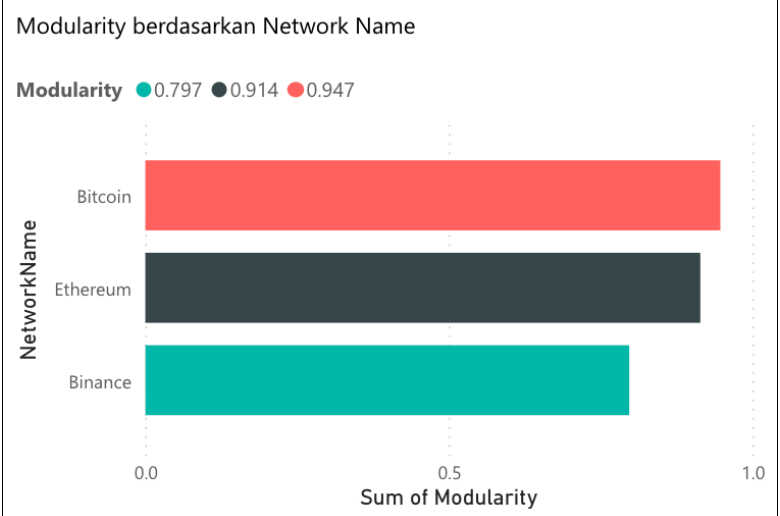
Figure 5(c). Modularity according to Cryptocurrency Name